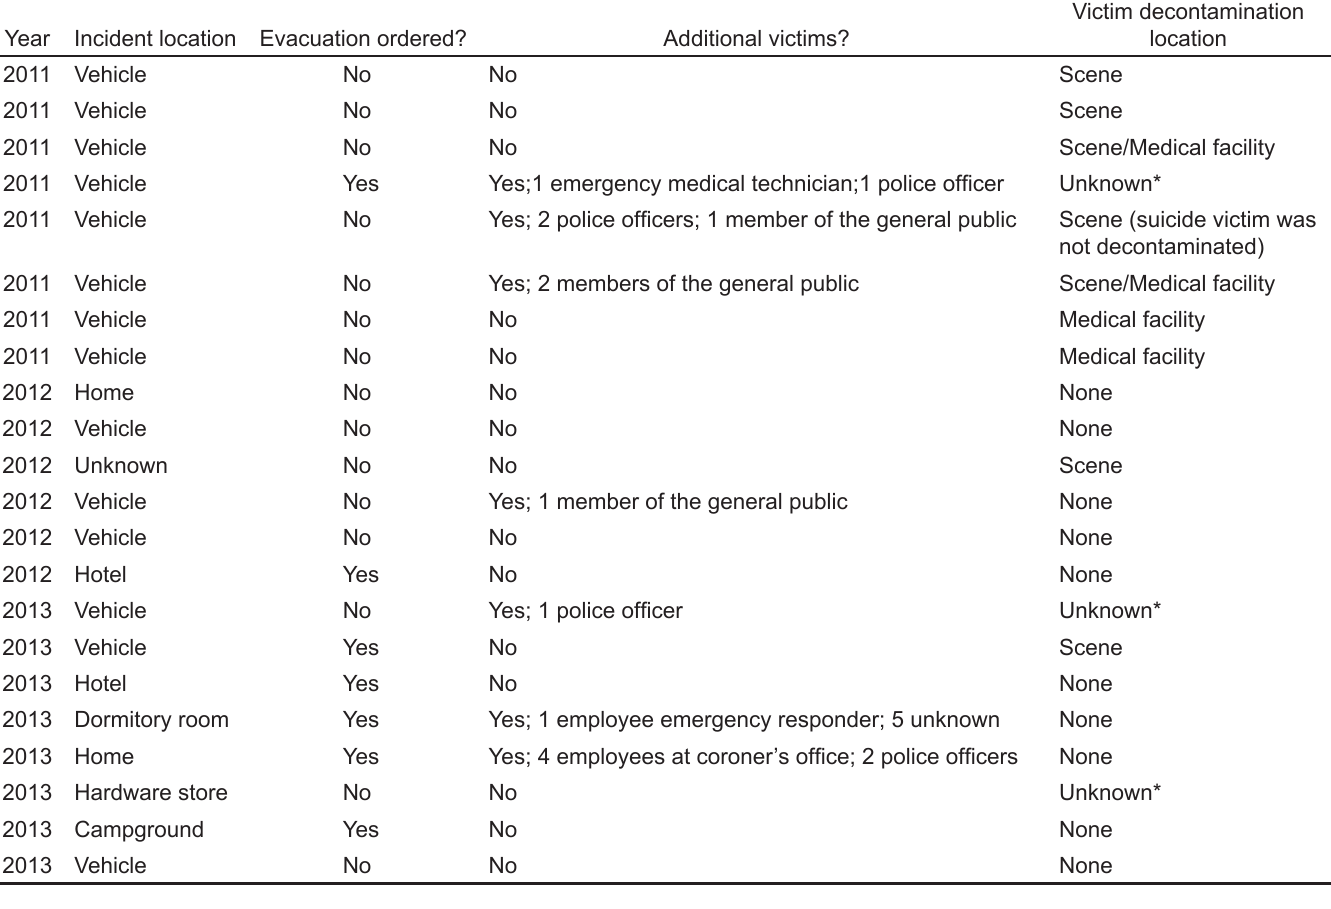
Table. Chemical suicides case characteristics, National Toxic Substance Incidents Program (NTSIP)